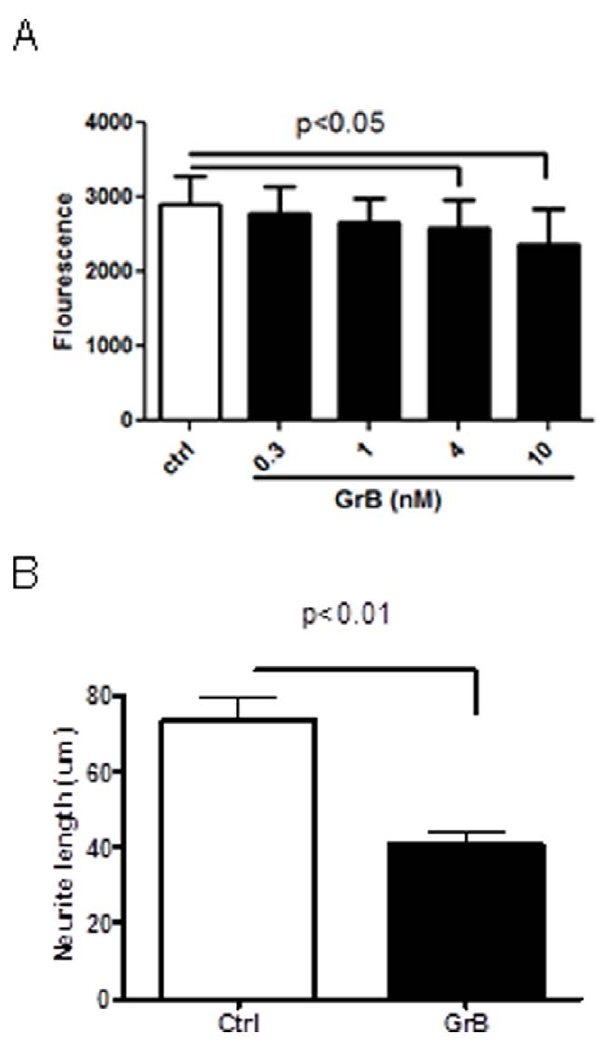
Figure 1. GrB induces neurotoxicity. (A) Human fetal neurons cultured in 96-well plates were treated with GrB (0.3–10 nM) for 24 hr and cell viability was measured using Cellquanti-blue assay. Results represent average 6 SEM from four independent fetal cultures. (B) Human fetal neurons on coverslips in 24-well plates were treated with GrB (4 nM) for 24 hr and neurons were immunostained for beta-III- tubulin. Average neurite lengths were measured as described in the methods section. Results represent average 6 SEM from three independent experiments.